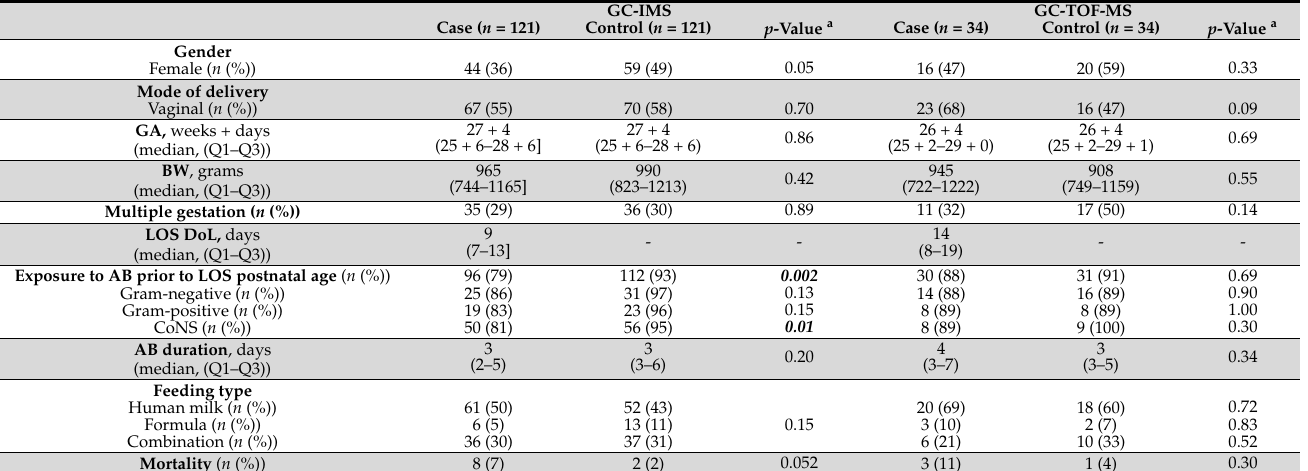
Table 1. Demographic